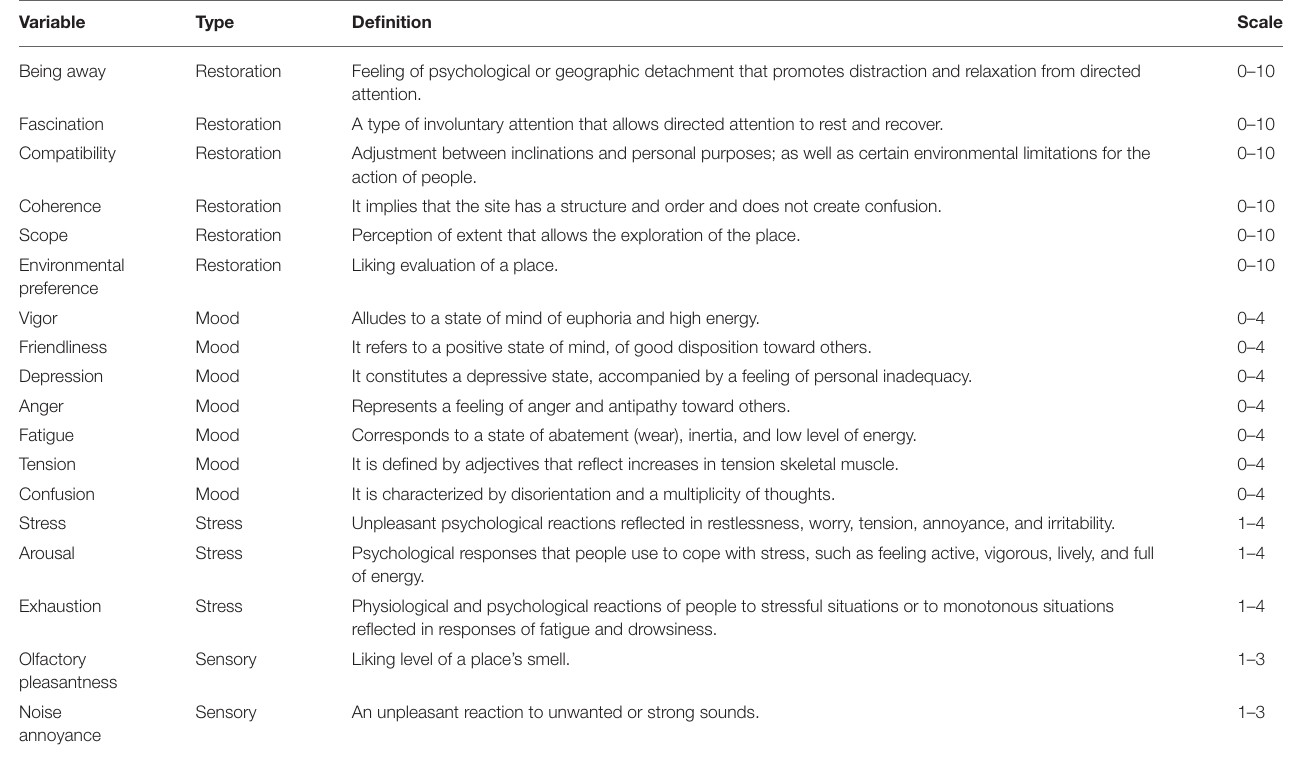
TABLE 1 | Psychological outcome and sensory